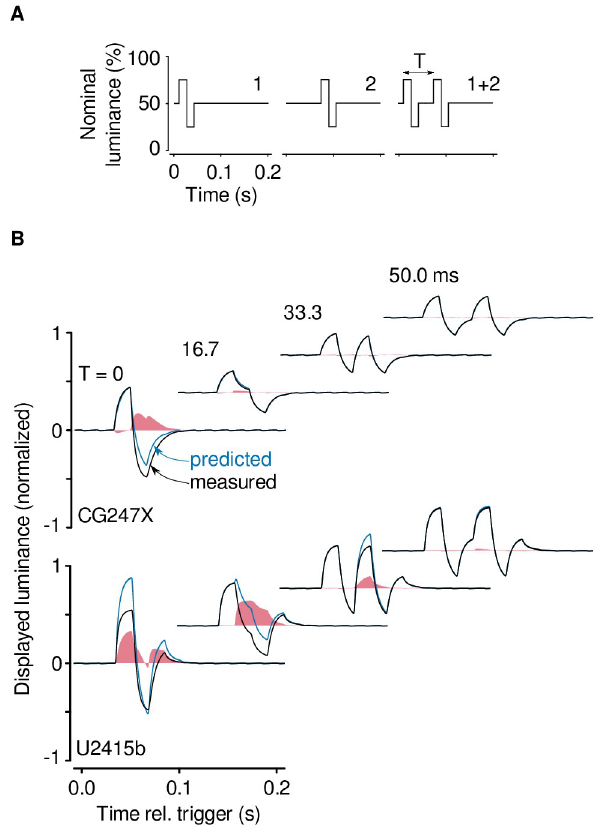
Fig 9. Paired luminance pulses revealed nonlinearities in displayed luminance. ( A ) Illustration of the paired-pulse paradigm. We presented a single biphasic luminance pulse (e.g., left panel), parametrically varying its latency relative to a trigger (cf. left and middle panels). We then presented a pair of biphasic luminance pulses (right panel), parametrically varying the offset between pulses comprising the pair, T = 0, 1, 2, and 3 times the frame period (frame period = 16.67 ms). Single-pulse responses can be used to predict the paired-pulse response; differences between this prediction and the displayed luminance model the display’s nonlinearities. ( B ) Nonlinear behaviour of the CG247X (upper). The four panels show responses to paired pulses with various offsets, T; we normalized responses (0, 0.5 and 1 corresponded to 0, 50 and 100% luminance, respectively) and then subtracted the baseline. For each offset, the predicted displayed luminance derived from single-pulse responses is shown in blue, and the measured displayed luminance in response to paired pulses is shown in black. The measured responses are an average of 16 recordings. The difference, that is, the nonlinearity, is shown in red. For the CG247X, superposition (T = 0 ms) of pulses evoked a nonlinearity which accelerated the transition from 100% luminance to 0% luminance. There was negligible nonlinearity of displayed lumiance for T > = 16.67 ms. Compared to the CG247X’s nonlinearity, the U2415b’s nonlinearity (lower panels) was large in magnitude and long-lasting, affecting subsequent frames (to T = 33.33 ms). Graphical conventions are as in